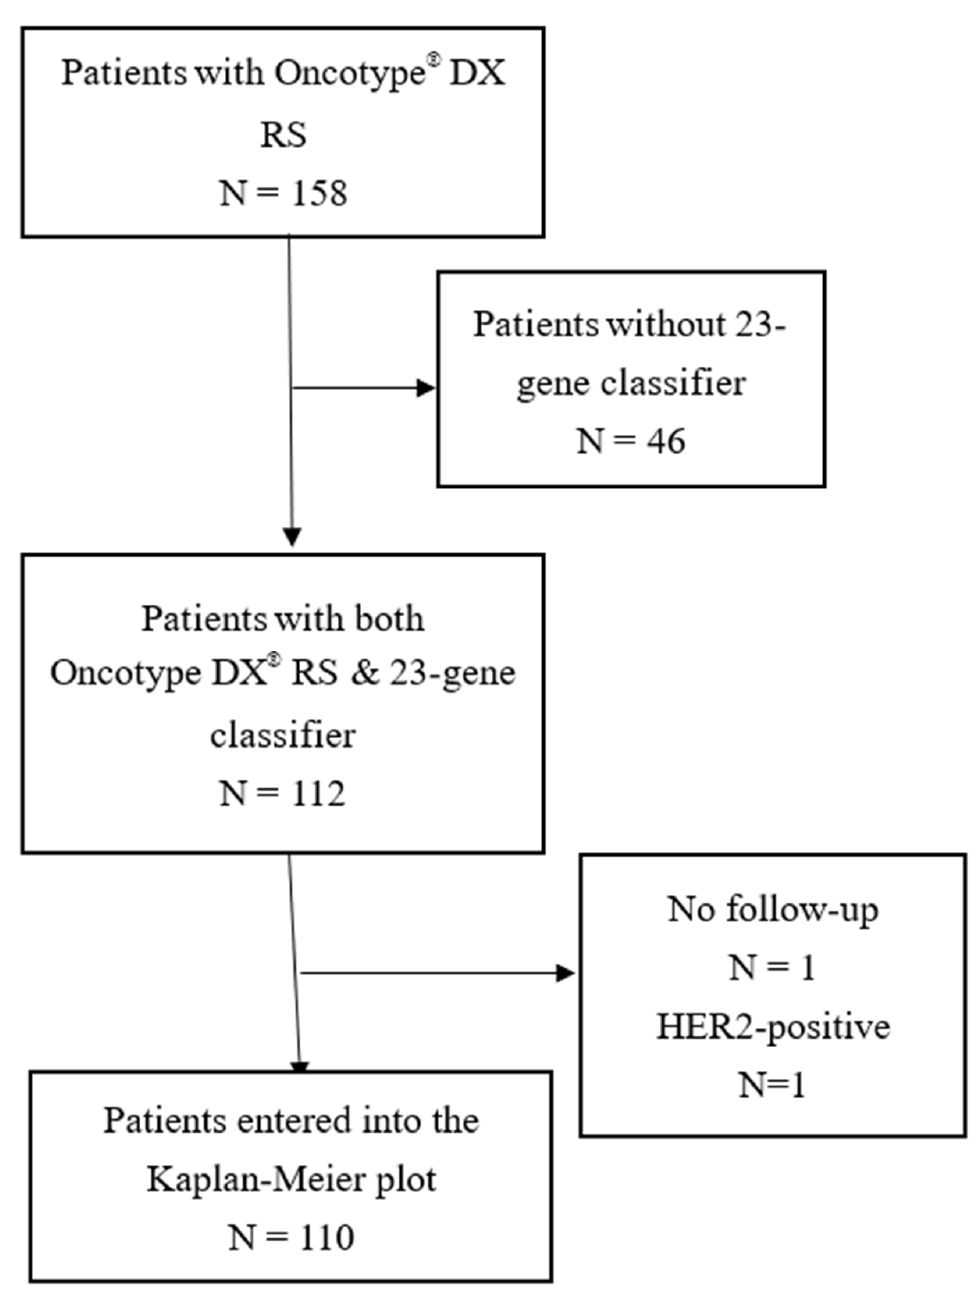
Figure 1. Patient selection.